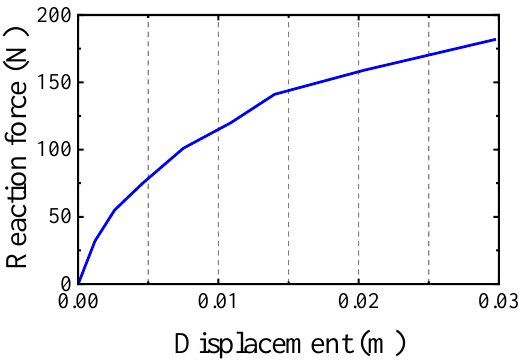
Figure 8. Load – displacement curve of the anchor under horizontal loads.